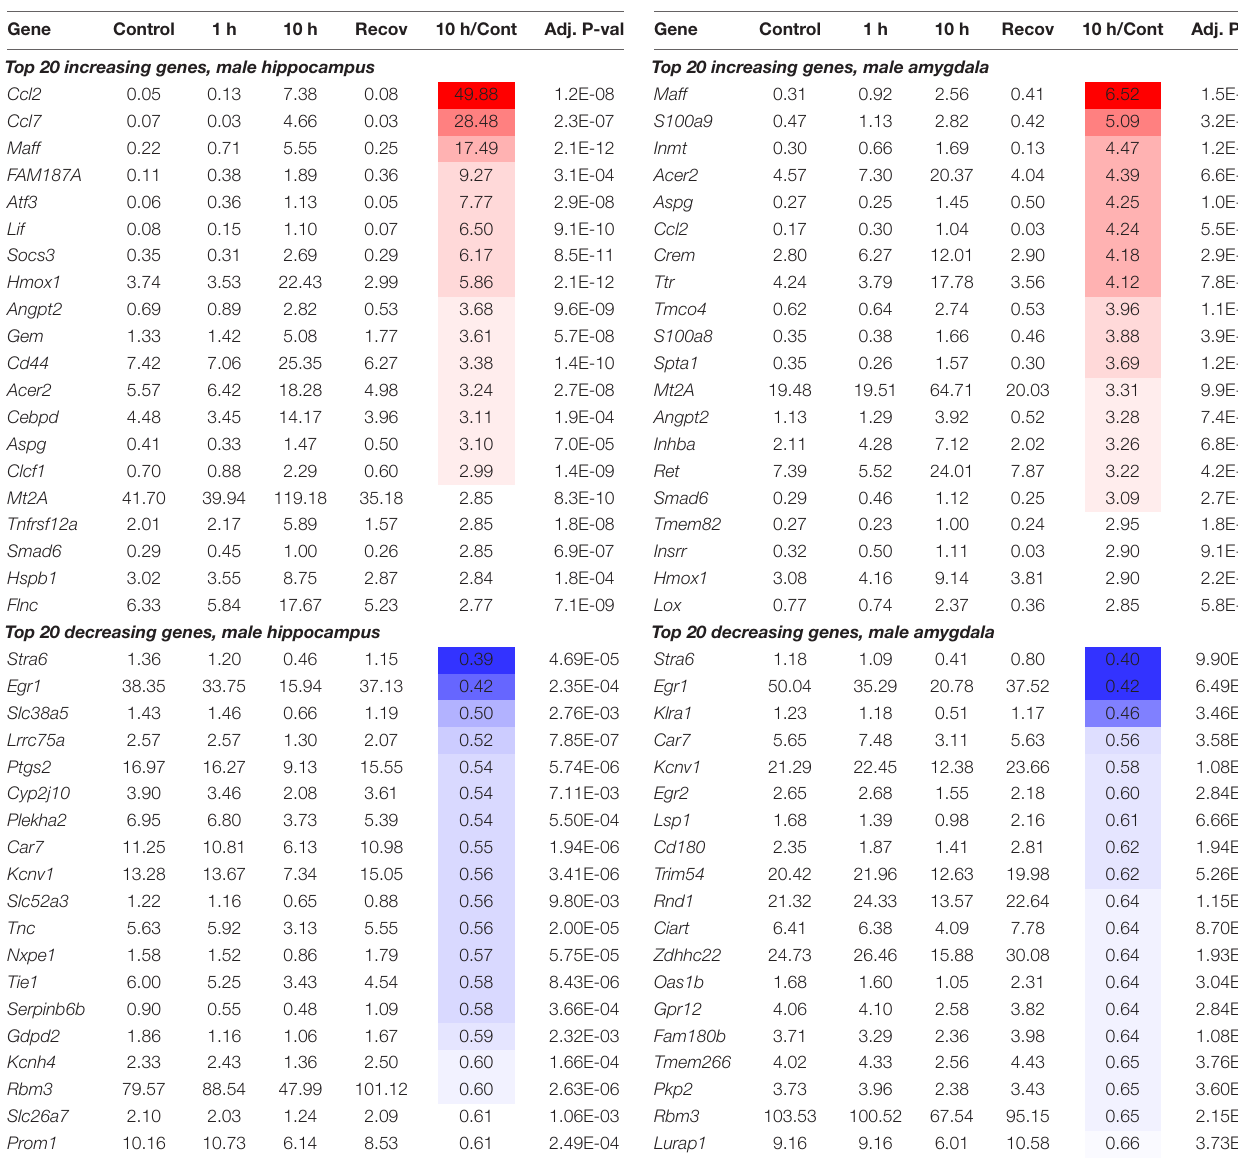
TABLE 3 | Male hippocampus top 20 increasing and decreasing genes. TABLE 4 | Male amygdala top 20 increasing and decreasing genes.